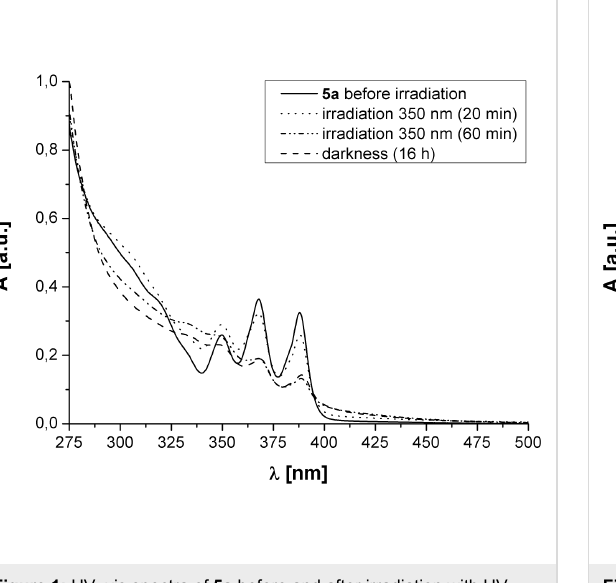
Figure 2: UV–vis spectra of 5b before and after irradiation with UV light.